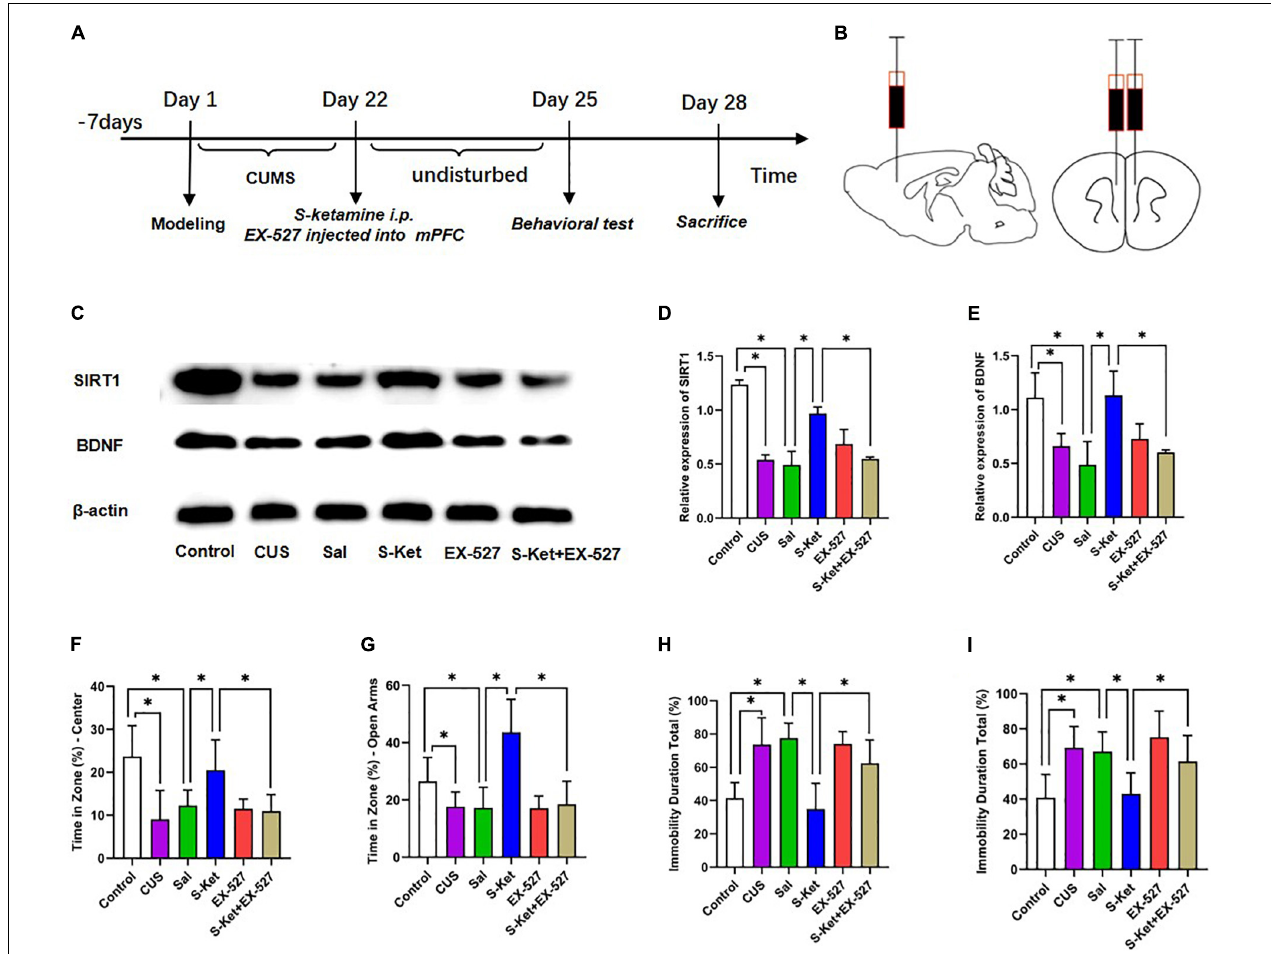
FIGURE 5 | Inhibition of SIRT1 protein reversed the antidepressant effect of S-ketamine. (A) Procedure of Experiment 1. (B) Injection location of SIRT1 inhibitor EX-527. (C) Bands of SIRT1 and BDNF obtained from the Western blot test. (D) Relative expression of SIRT1 protein ( n = 6). (E) Relative expression of SIRT1 protein ( n = 6). (F) Motion trail and time of the center zone in OFT ( n = 6–8). (G) Motion trail and time of the open arms in EPM ( n = 5–9). (H) Percentage of immobile time in the TST ( n = 8–9). (I) Percentage of immobile time in the FST ( n = 7–9). The data are expressed as the mean ± standard error, and ∗ P <